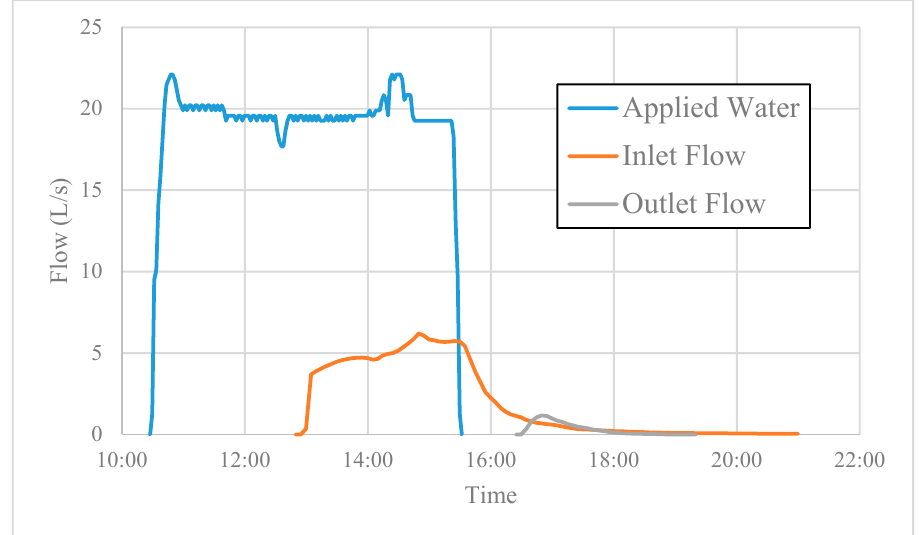
Figure 2. Flow rate of applied water from sprinklers and of runoff entering and exiting the vegetated treatment ditch. Table 3. Inflow and outflow water volumes for the 12 November trial, as well as insecticide and total suspended solid concentrations, and relative concentration and load reductions for all trials. Load reductions for the 24 September and 8 October trials were estimated (*) based on flow measurements taken during the 12 November trial. ND indicates non-detect. NR indicates not recorded due to equipment